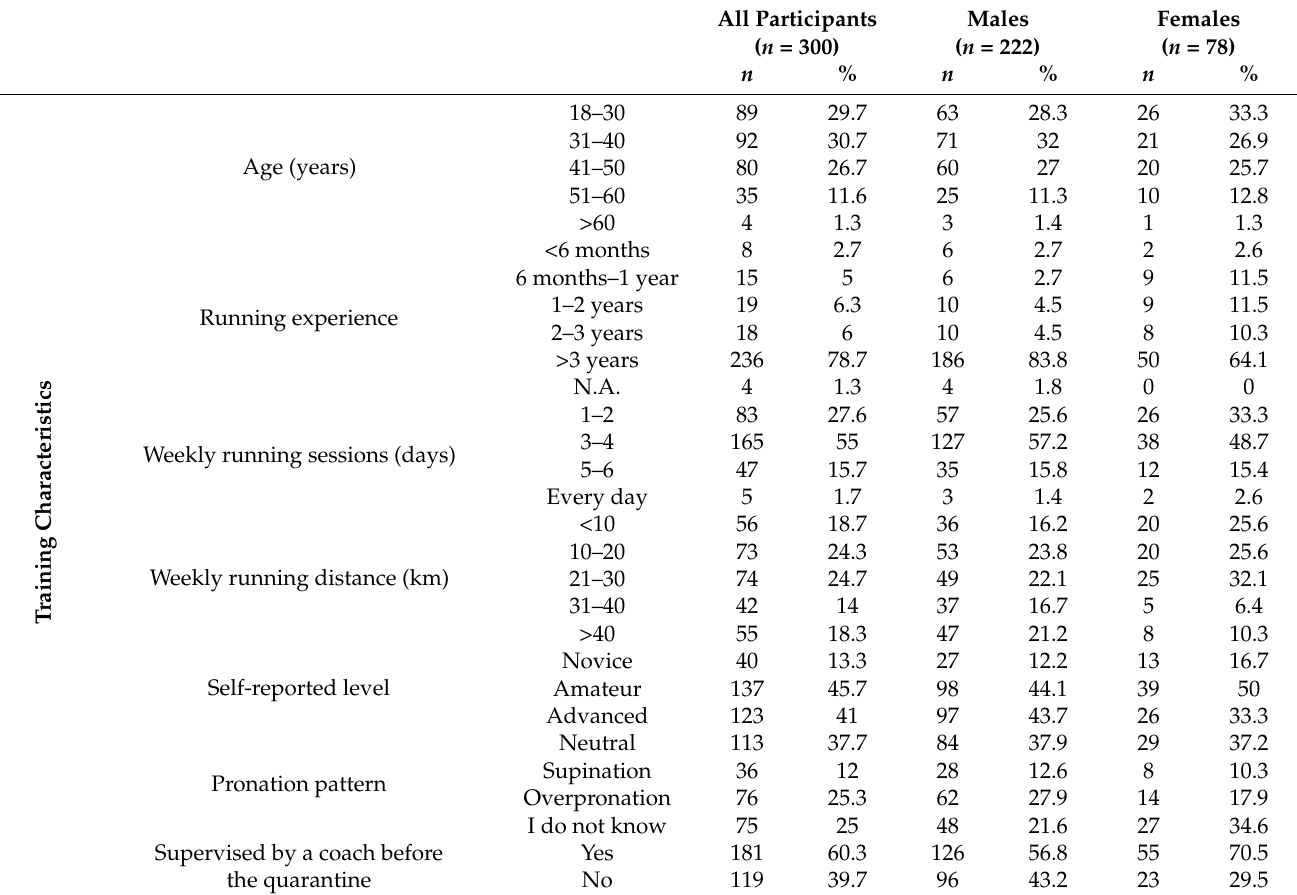
Table 1. Training characteristics of recreational runners in Spain before the 48-day home quarantine. All